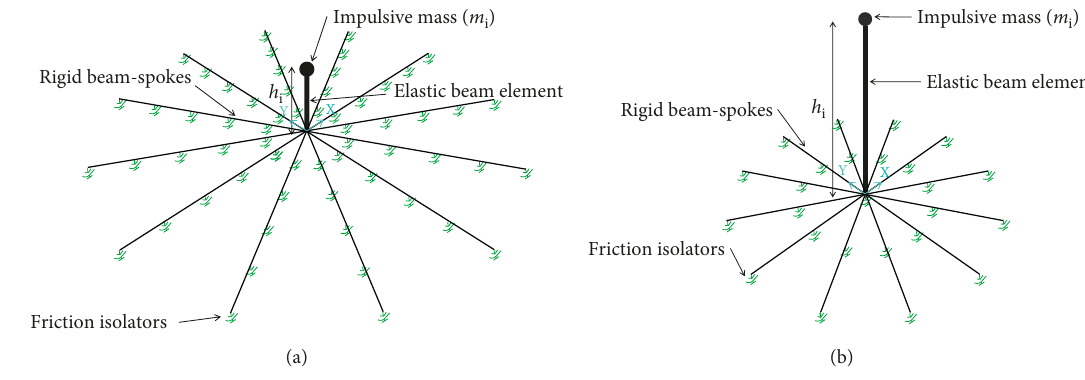
Figure 6: Joystick models for a squat (a) and a slender tank (b). Table 2: Design parameters for the TFPB isolated squat tank.